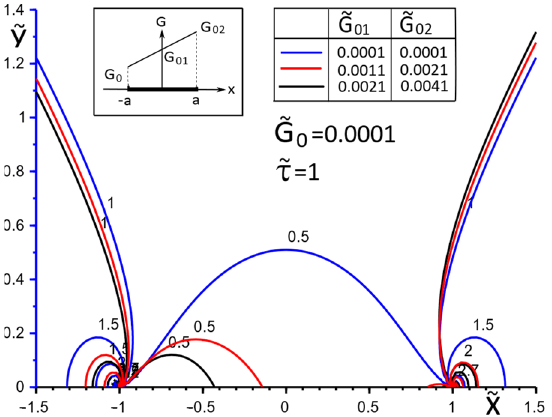
Figure 8. Stress distribution along with the upper interface (inclusion—matrix half-space S 2 ) with a piecewise linear distribution of material stiffness.